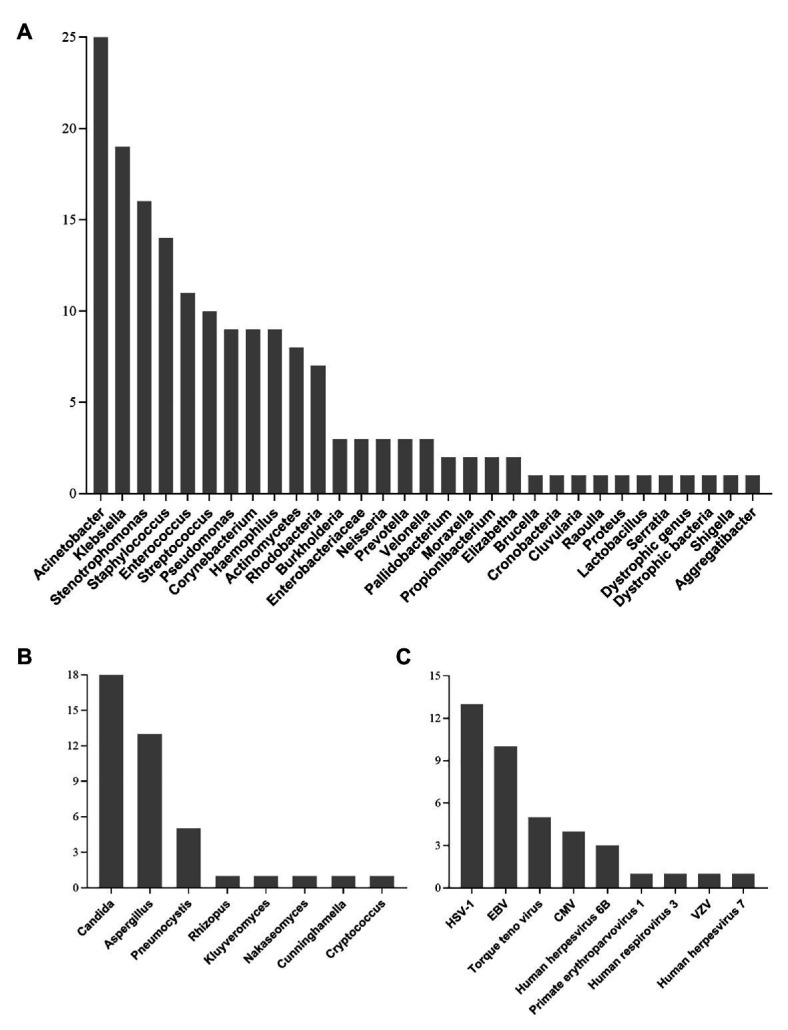
Genus distribution of bacteria (A), fungi (B), and virus (C) detected by mNGS technique. Acinetobacter, Candida, and HSV-1 were the most commonly detected bacteria, fungi, and viruses, respectively. HSV-1, Herpes simplex virus 1; EBV, Epstein-Barr virus; CMV, Human cytomegalovirus; VZV, varicella zoster virus.